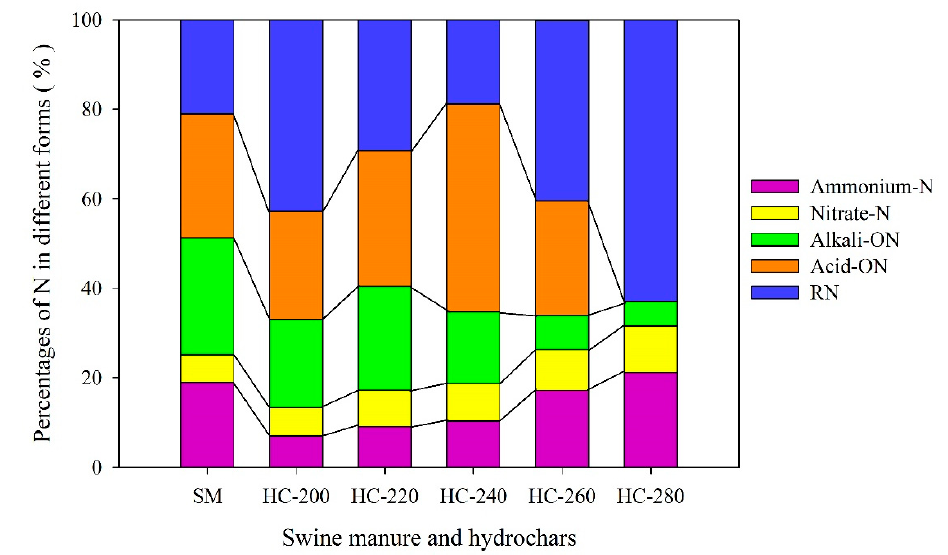
Figure 4. Changes in the forms of N between raw SM and hydrochars obtained at different reaction temperatures. Table 3. Different forms of nitrogen in raw SM and hydrochars obtained at different reaction temperatures (mg/g, dry basis). Sample